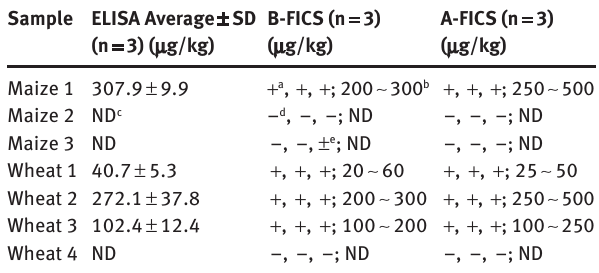
Table 2: Comparison of the developed BP-Au nanocomposite- based fluorescent quenching immunochromatographic sensor (B-FICS), gold nanoparticles (AuNPs)-based fluorescence quenching immunochromatographic sensor (A-FICS) and the commercial ELISA kit for the detection of zearalenone (ZEN) in real cereal